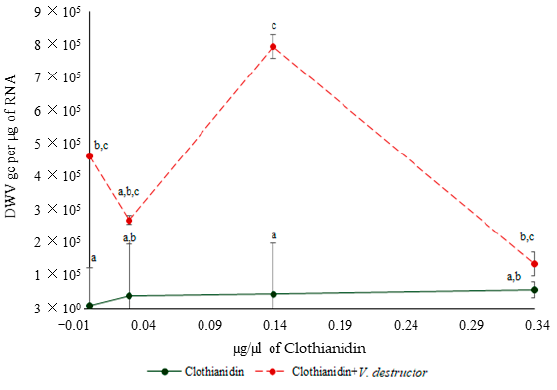
Figure 3. Mean DWV genome copies (GCs) per µg of RNA (± S.E.) of bees that were exposed to clothianidin and/or V. destructor . Different letters (a, b and c) above the bars indicate significant differences based on a Kruskal–Wallis test and Conover Iman procedure. Non-transformed data are presented.